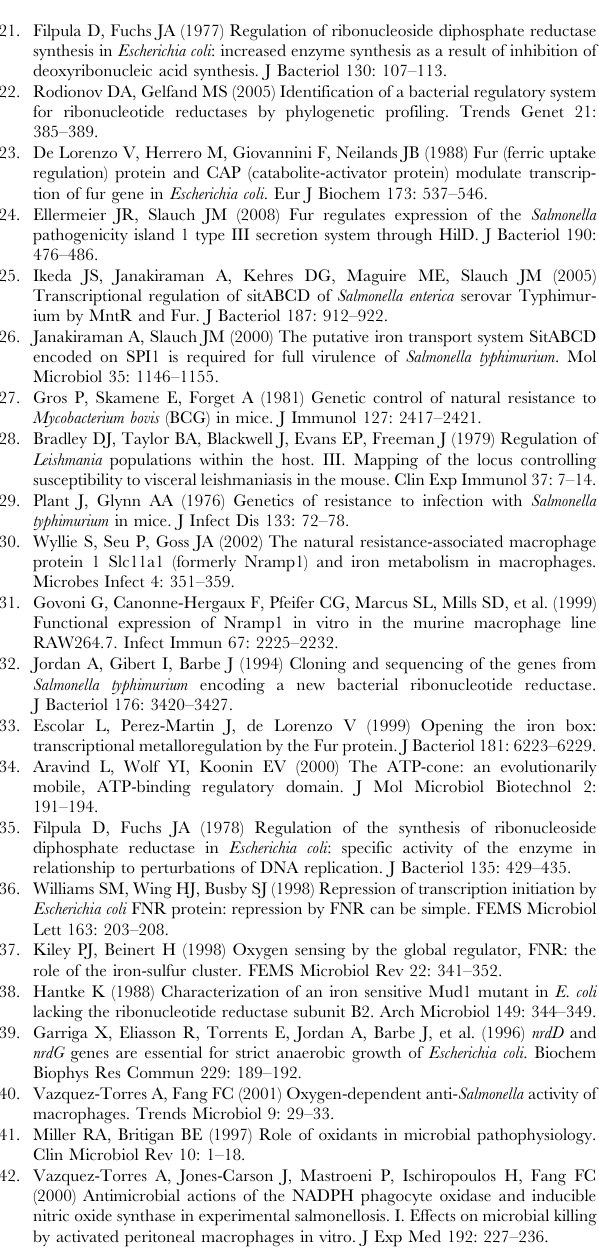
Figure S1 Effect of D fur mutation on nrdAB expression b - galactosidase activity is expressed in Miller Units (MU) for the wild-type strain (Wt) and mutant D fur strain (Fur - ). Figure S2 Effect of nrd mutants on growth rate. (A) Growth curve of the nrdA 9 :: V Cm 9 nrdB D fur ( D AB- D fur), nrdA 9 :: V Cm 9 nrdB D nrdDG D fur ( D AB- D DG- D fur), nrdA 9 :: V Cm 9 nrdB D nrdDG D nrdR ( D AB- D DG- D R) and Wt (SL1344) strains from S. Typhimurium growing under aerobic conditions together with (B) viable counts. Found at: doi:10.1371/journal.pone.0011328.s003 (0.10 MB TIF) Figure S3 Effect of NrdR and Fur mutants on growth rate. Growth curves for the Wt, NrdR and Fur mutant Salmonella strains.